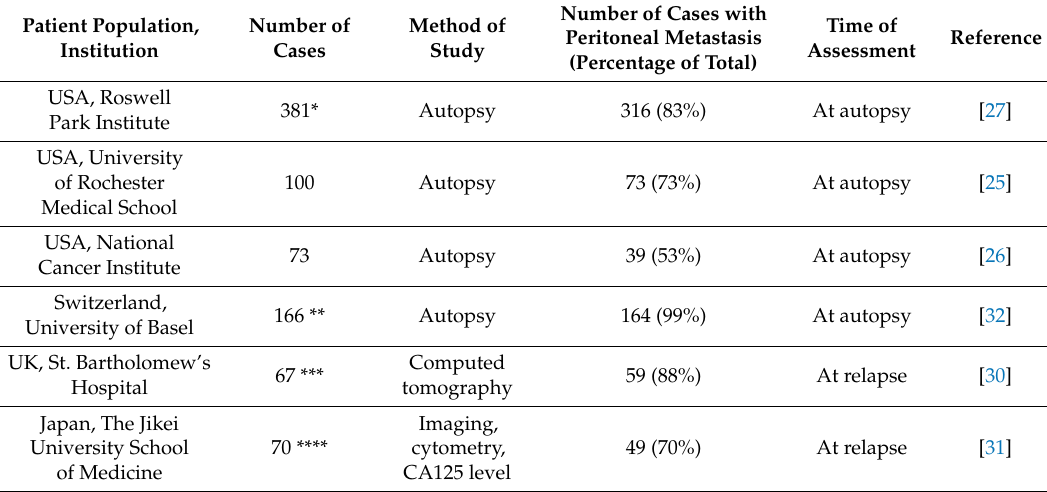
Table 1. Prevalence of peritoneal metastasis in patients with epithelial ovarian carcinoma (EOC). USA—United States of America; UK—United